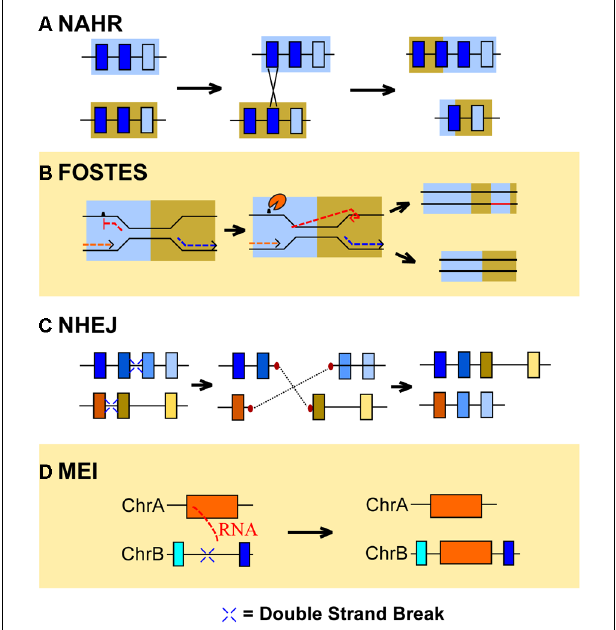
FIGURE 1 |The molecular mechanisms of CNV formation. Currently identified mechanisms of copy number variation (CNV) formation include non-allelic homologous recombination (NAHR), fork stalling and template switching (FOSTES), non-homologous end-joining (NHEJ), and mobile element insertion (MEI). (A) NAHR generates CNVs when a genomic segment with high sequence similarity to another, non-allelic locus (blue boxes) recombines.The results of this recombination can generate a duplication of the similar locus on one chromosome, while removing the copy from the other. (B) FOSTES occurs when the DNA replication complex stalls due to DNA lesions or chemical modifications of the nucleoside bases (hatch mark) and the lagging strand of DNA (red dashed line) associates with a different region of the genome with high sequence similarity.The location of the association determines if a duplication (pictured) or deletion occurs. (C) Double stranded breaks in DNA sequence (blue crosses) prompt NHEJ associated proteins to repair and ligate DNA strands together. First, end-repair (red ovals) replaces lost nucleotides on the double strand break and DNA ligase associates broken DNA fragments together. If fragments from different chromosomes ligate together, duplications or deletions of sequence can occur. (D) Retrotransposition involves an RNA intermediate (red dashed lines) that is reverse transcribed into cDNA and is subsequently inserted into the genome, thereby causing a duplication of the original endogenous